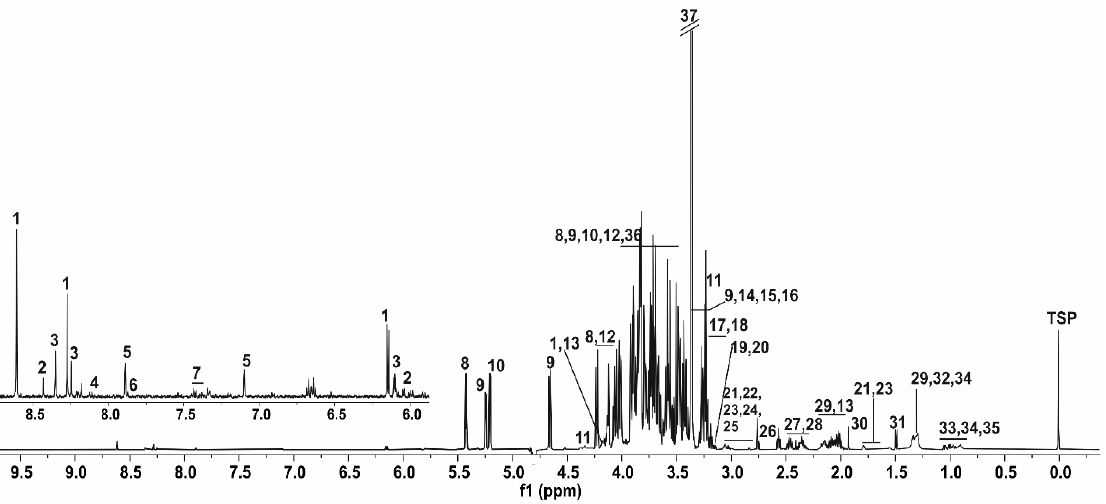
Figure 1. Typical proton nuclear magnetic resonance ( 1 H NMR) spectrum of honey bee worker body (gut and venom sac excluded). The numbers correspond to these quantified compounds: 1. Aden- osine monophosphate (AMP), 2. Oxidized nicotinamide adenine dinucleotide (NAD + ), 3. Ino- sine, 4. Adenine, 5. Histidine, 6. Uridine, 7. Phenylalanine, 8. Sucrose, 9. Glucose, 10. Trehalose, 11. sn -glycero-3-phosphocholine, 12. Fructose, 13. Proline, 14. O -phosphocholine, 15. Taurine, 16.